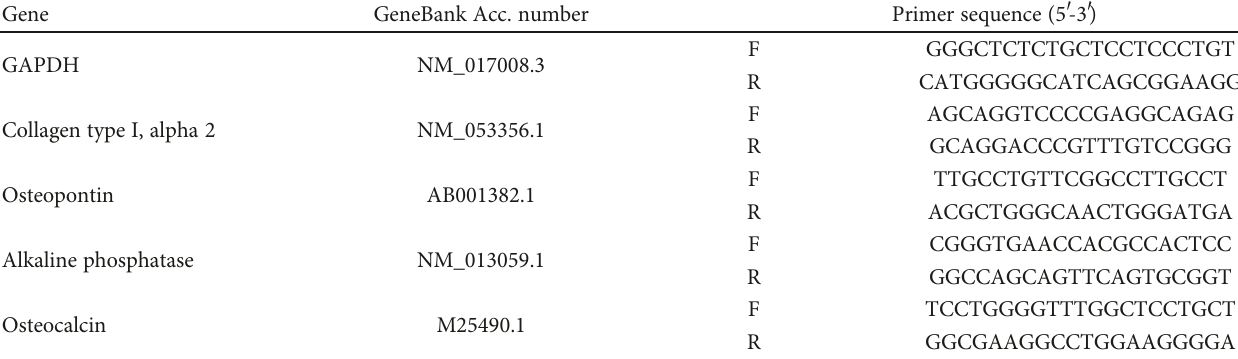
Table 1: Primers for reverse transcription polymerase chain reaction (RT-PCR) analysis of gene expression. Gene